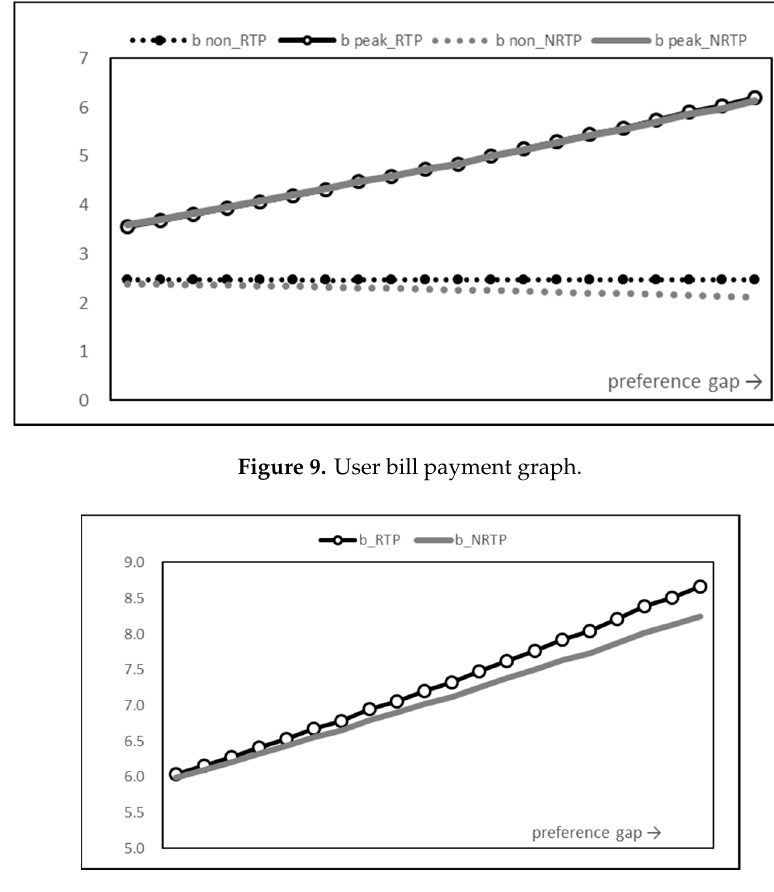
Figure 10. Total bill payment graph.